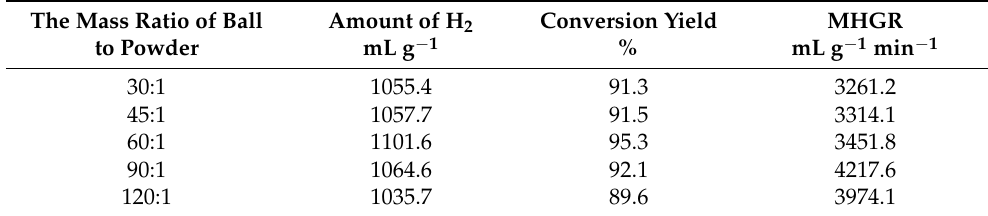
Table 3. Hydrogen generation performances of Al-15 wt% BiOI with different mass ratios of ball to powder at 298.15